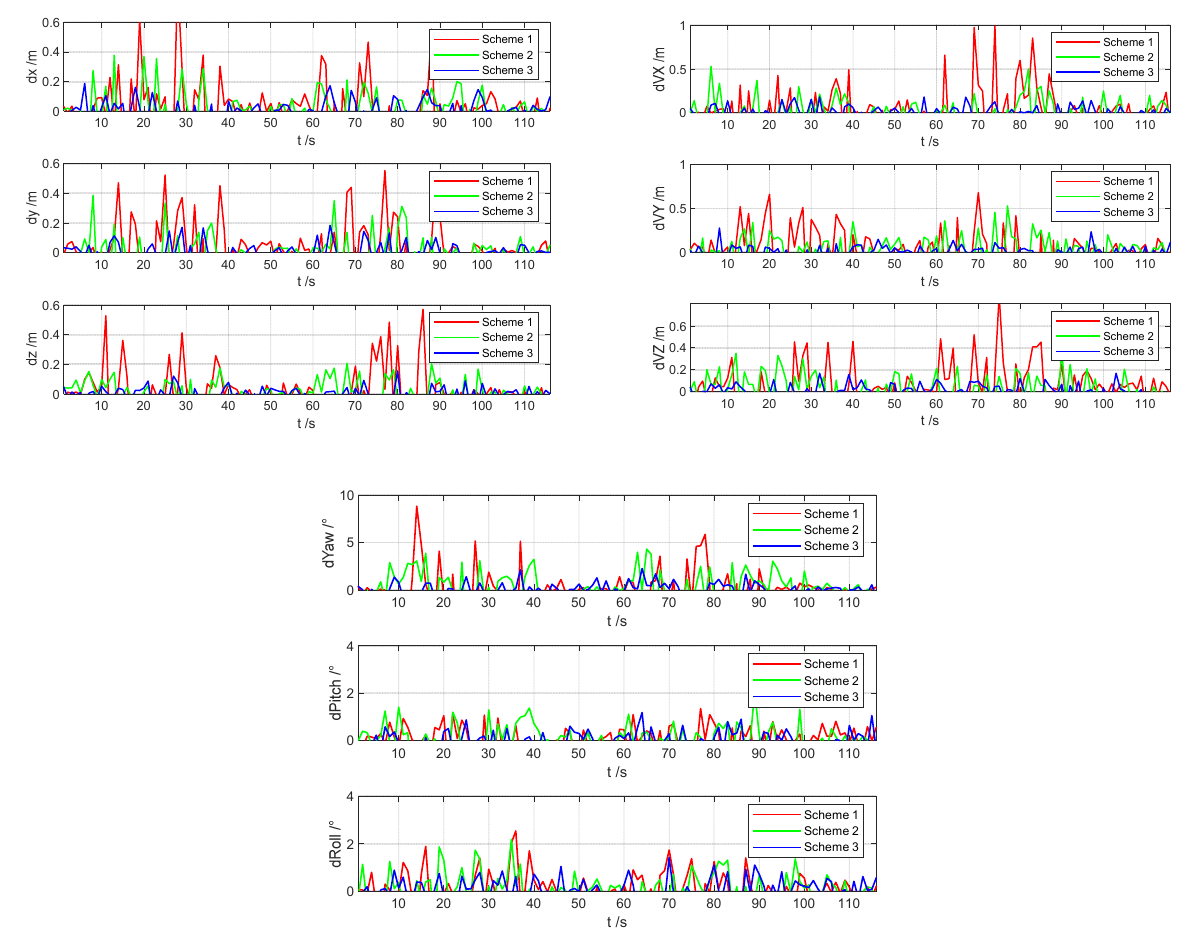
Figure 14. Comparison of position, speed, and attitude errors of different schemes.